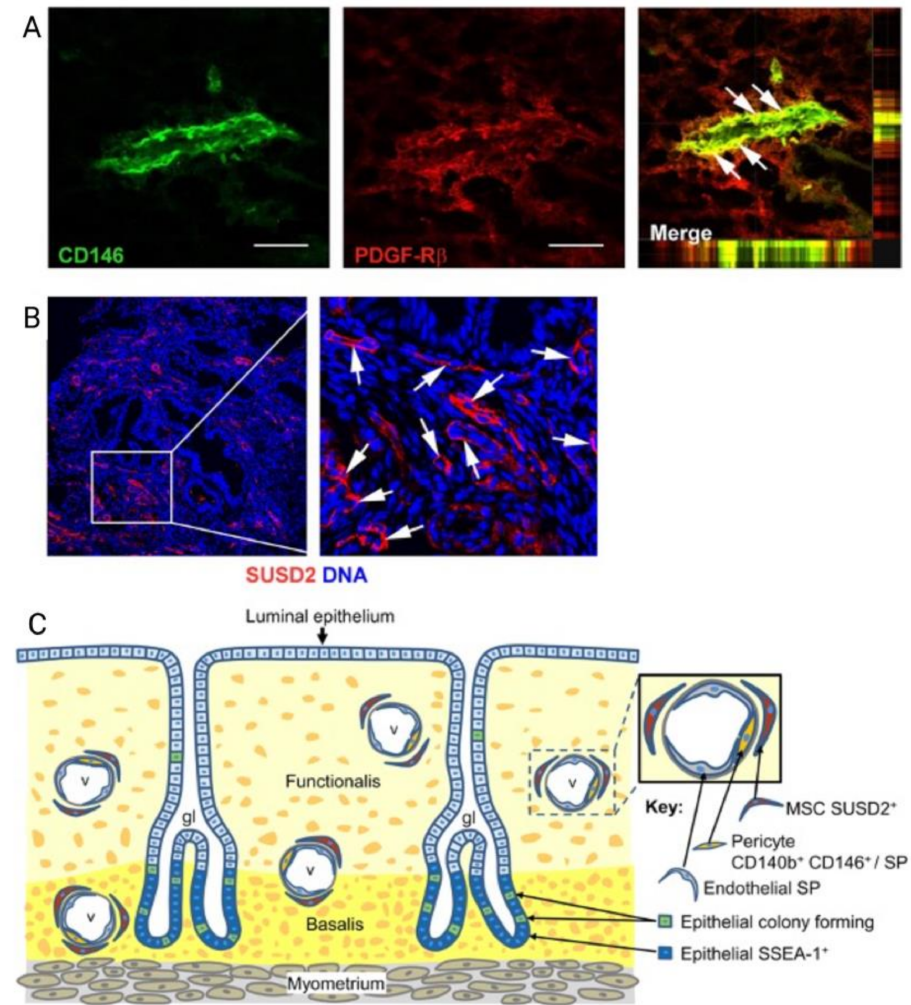
Figure 5. Localisation of human endometrial mesenchymal stem cells (eMSC). ( A ) Immunofluores- cence images of human endometrium showing colocalization markers CD146 and platelet derived growth factor receptor beta (PDGF-R β , CD140b) to reveal the perivascular niche of eMSC (merge in the right of panel A ); ( B ) perivascular Sushi Domain containing-2 (SUSD2) expression show- ing perivascular location (white arrows); and ( C ) Schematic showing the perivascular identity of co-expressing CD146 and PDGFR β /CD140b and SUSD2 + eMSC in the endometrial basalis and functionalis layer, indicating eMSC will be shed into menstrual blood. Scale bar in ( A ) = 50 µ m. Reprinted with permission from Gargett et al. (2010) [65]. Copyright Oxford University Press,